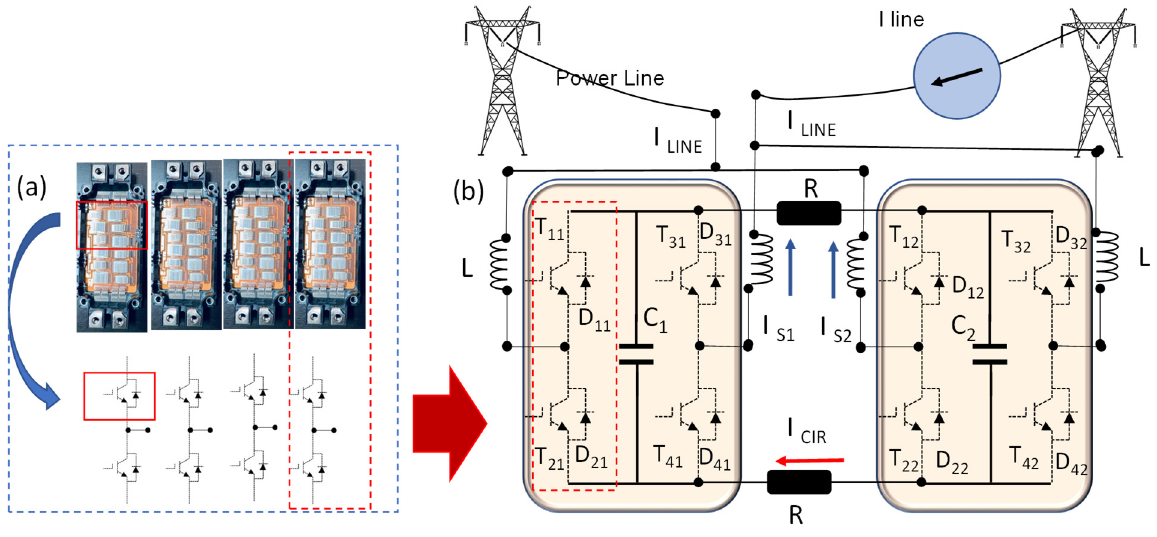
Figure 9. Embedding paralleling strategy from dices to modules to converters with inductive and resistive balancing network (R and L). ( a ) Four parallel modules form one IGBT; ( b ) One converter leg (red dotted line on panel b) is formed by four modules as indicated in top portion of panel a, or bottom circuit diagram of panel a